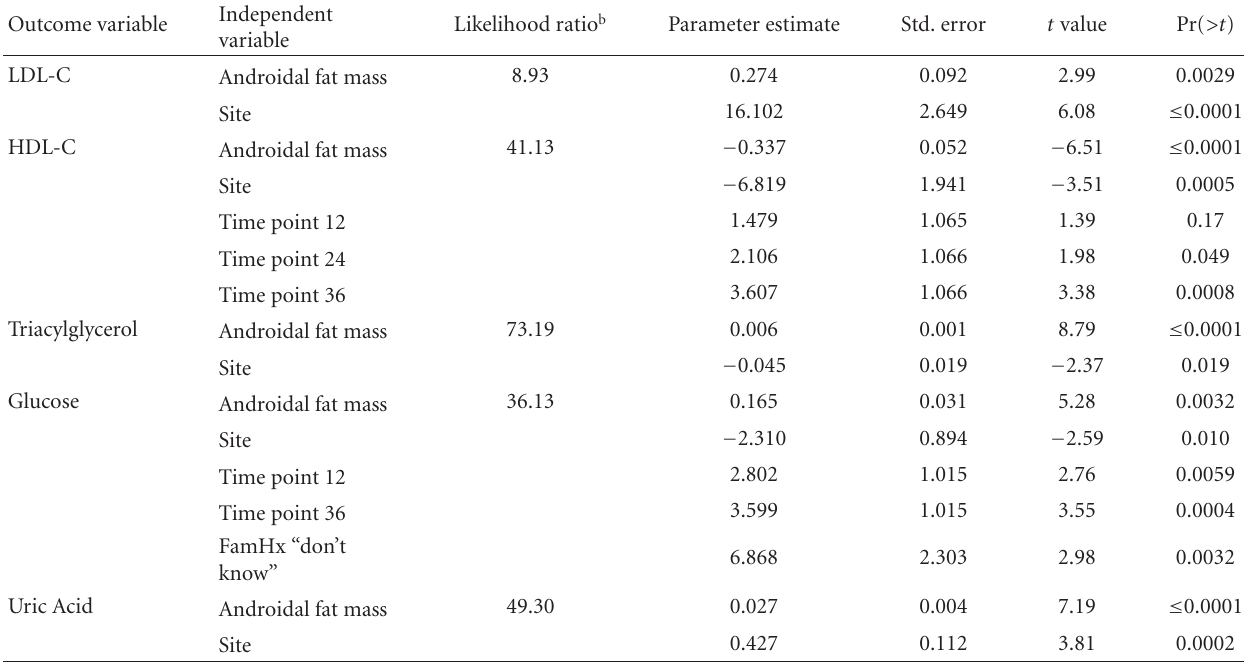
Table 2: Longitudinal analysis: covariates associated with each outcome variable a assessed from baseline through 36 months ( N = 224). Outcome